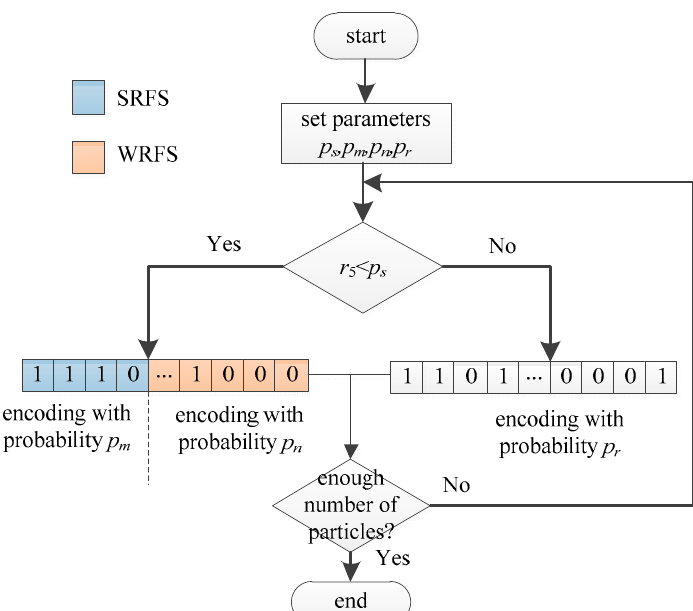
Figure 2. Flowchart of the new particle encoding strategy.